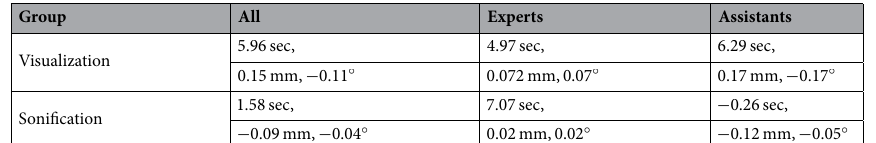
Table 5. The mean of differences for entry point (CT) error, angle (CT) error, and alignment time between the 1st. and 2nd. executions for each expertise group.